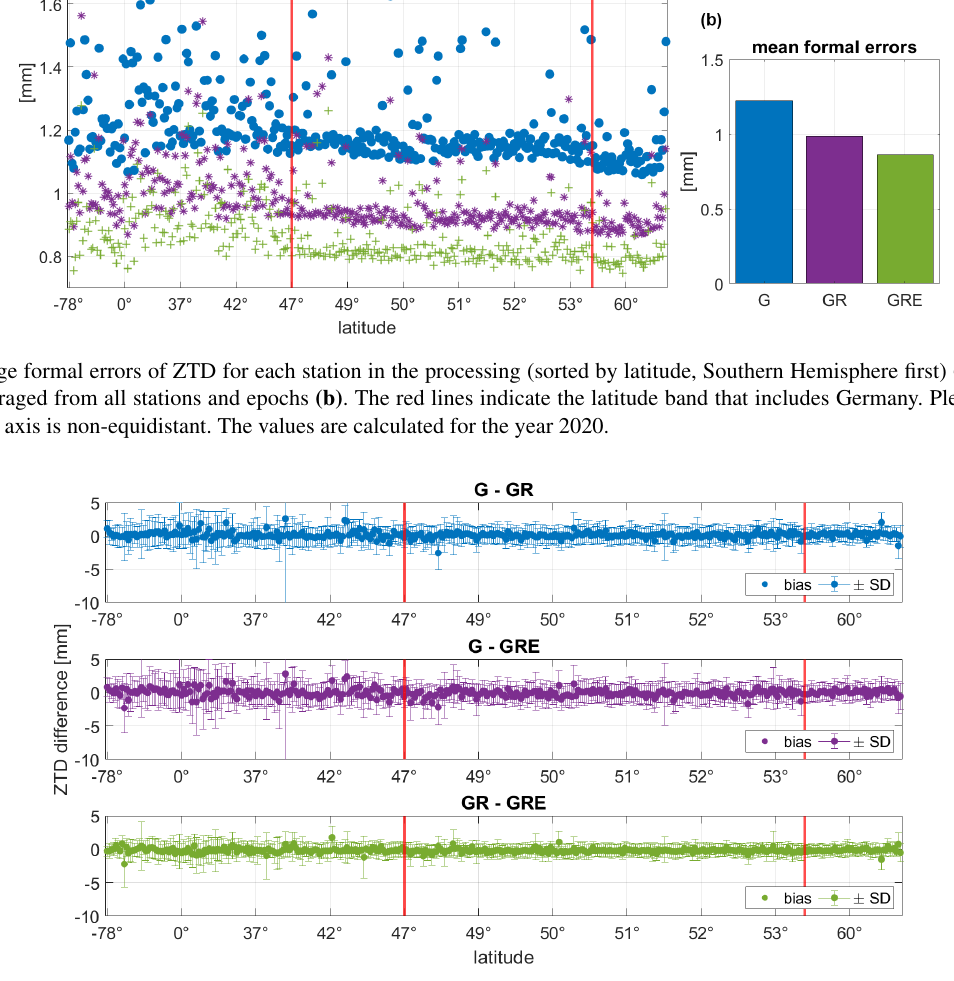
Figure 4. The ZTD biases and SDs for each station (sorted by latitude, Southern Hemisphere first) between the three different GNSS solutions. The red lines indicate the latitude band that includes Germany. Please note that the labeling of the x axis is non-equidistant. The statistics are calculated for the year